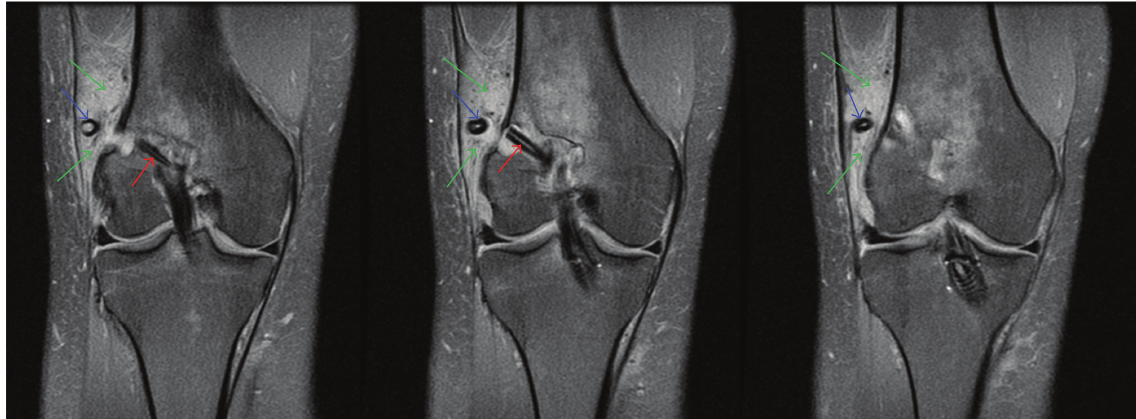
Figure 2: Coronal fat suppressed T2-weighted images demonstrate that the proximal portion of the pin has backed out of the distal femur and is found within the adjacent soft tissues where it is surrounded by edema (blue arrows) and a thickened iliotibial band (green arrows). The distal portion of the pin (red arrows) and ACL graft are intact.